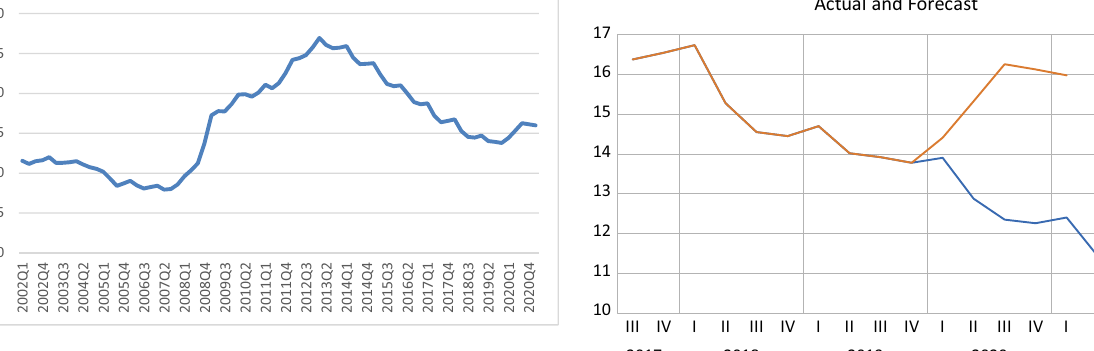
Figure 1: Unemployment rate in Spain. Source: “ Instituto Nacional de Estadística ” in Spain, https://www.ine.es.